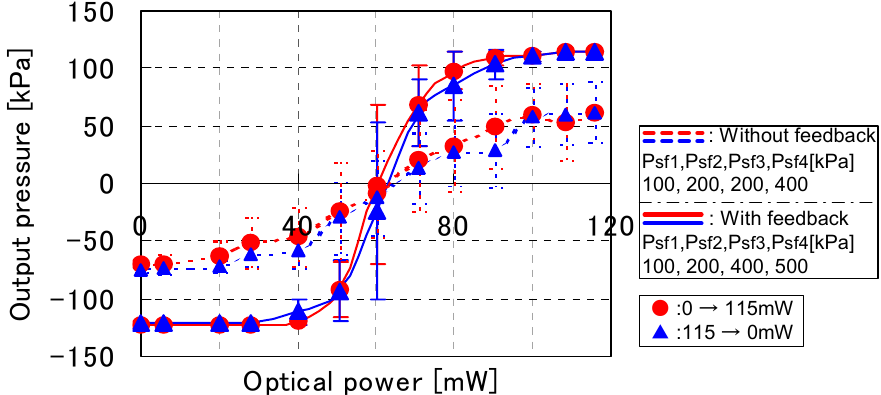
Fig. 9 Relation between optical power and output pressure of the improved